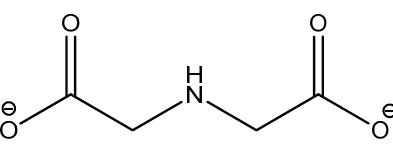
Figure 13. IDA (iminodiacetate).